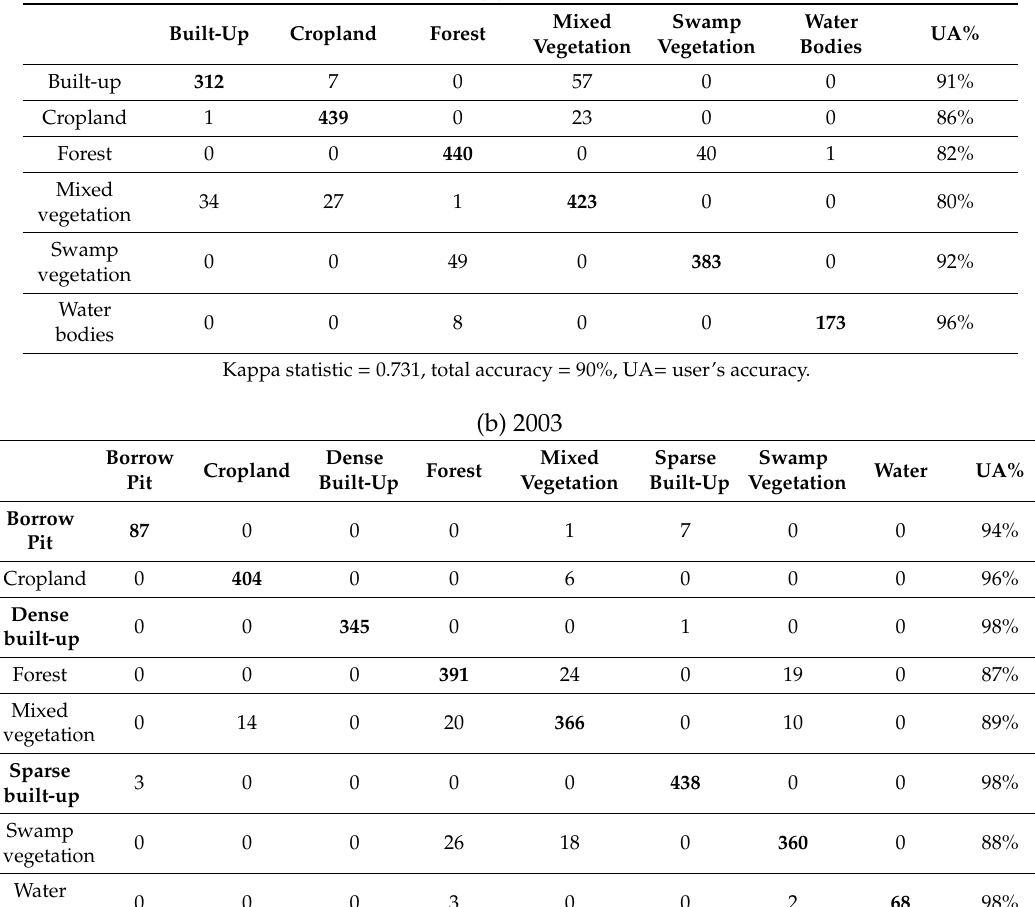
Table 2. Landsat 1986, 2003, and 2017 image classification confusion matrix class. (a)